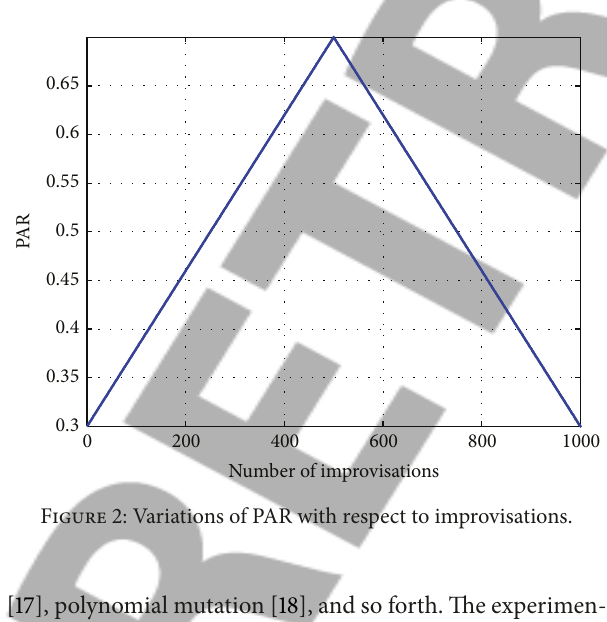
Figure 2: Variations of PAR with respect to improvisations.